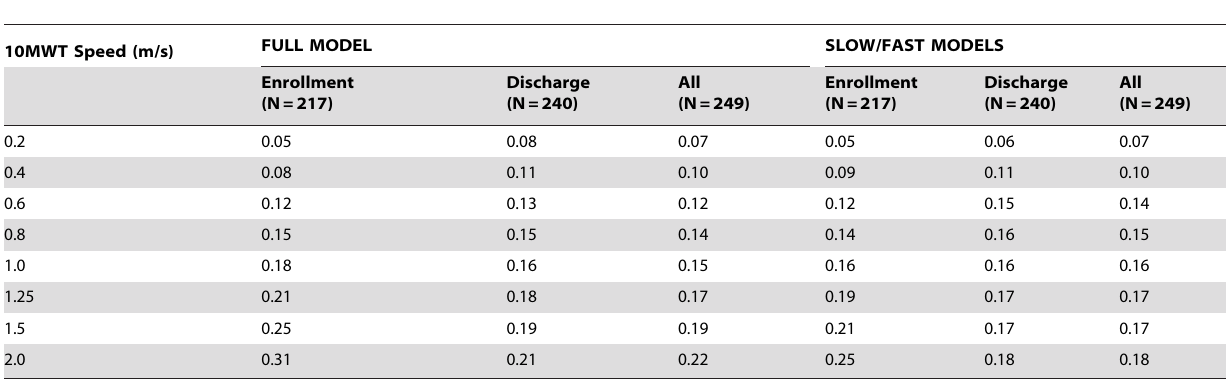
Table 3. Residual standard errors for linear models using 10MWT speeds to predict 6MWT speeds at selected speeds.